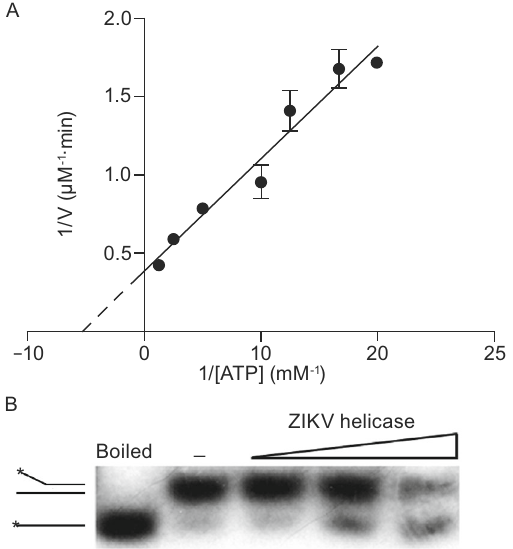
Figure 1. The ATPase and RNA unwinding activities of ZIKV helicase. (A) Determination of ATP hydrolysis activity of ZIKV helicase. The ATPase assay was carried out with 20 nmol/L of enzyme in the presence of the indicated concentrations of ATP for 20 min at 25°C. The double- reciprocal plot was fi tted according to the Michaelis-Menten equation. (B) Measurement of dsRNA unwinding activity of ZIKV helicase. RNA unwinding activity of ZIKV helicase was assayed using a radiolabeled dsRNA substrate. The fi rst lane is the positive control (heat-denatured duplex) and the second lane is the negative control (without ZIKV